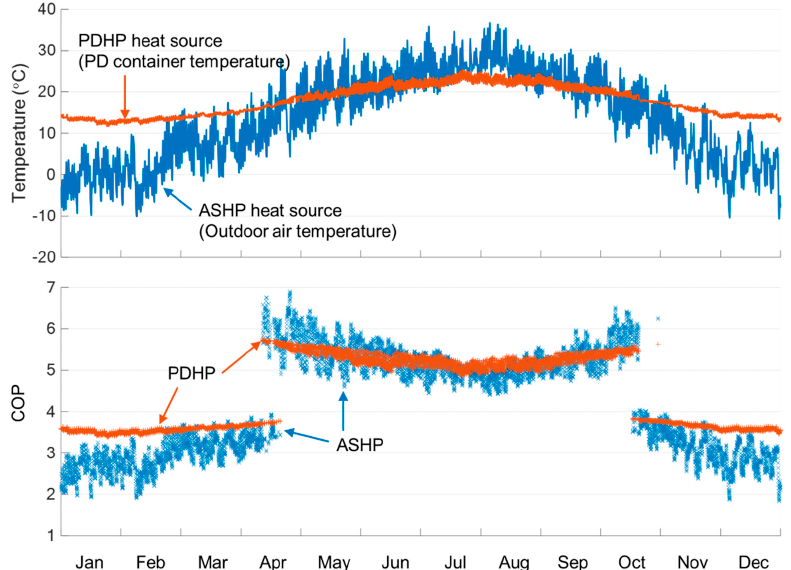
Figure 12. Simulation results of heat pump COPs and heat source temperatures for PDHP and ASHP.